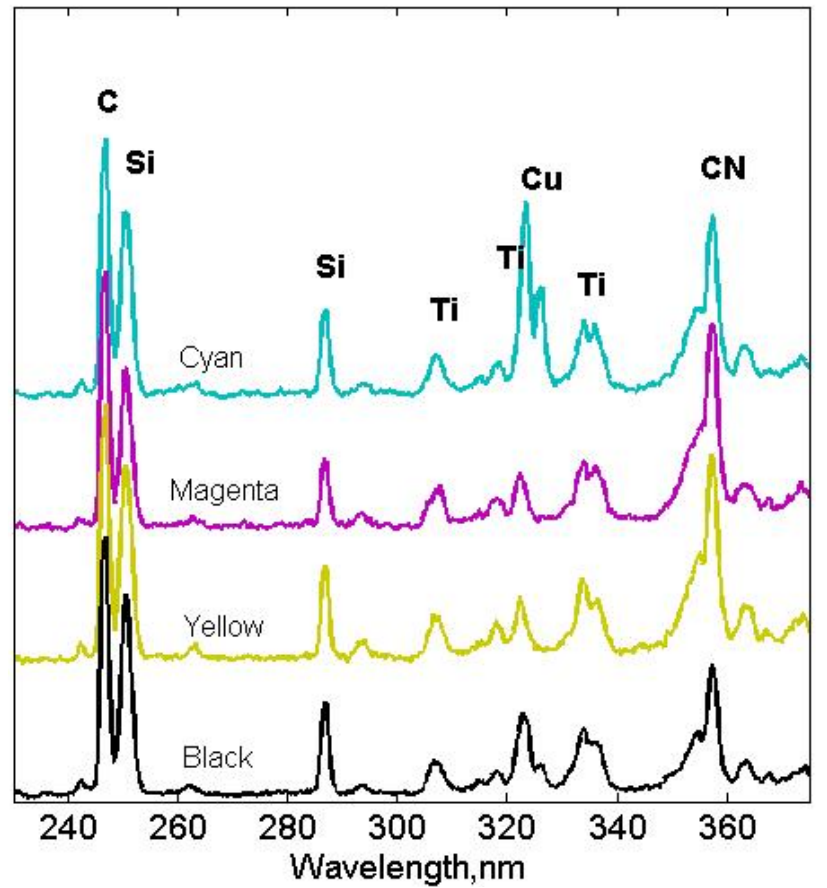
Figure 4. LIPS spectra of the four conventional toners, cyan, magenta, yellow and key (black), (CMYK), used in the printing industry in the wavelength region from 200 nm to 400 nm. The carbon signal arises from carbon black, latex or cellulose constituents of a toner. Silicon and titanium are present in all toners. The copper signal is indicative of a cyan dye and is seen also in the black toner as a small signal.